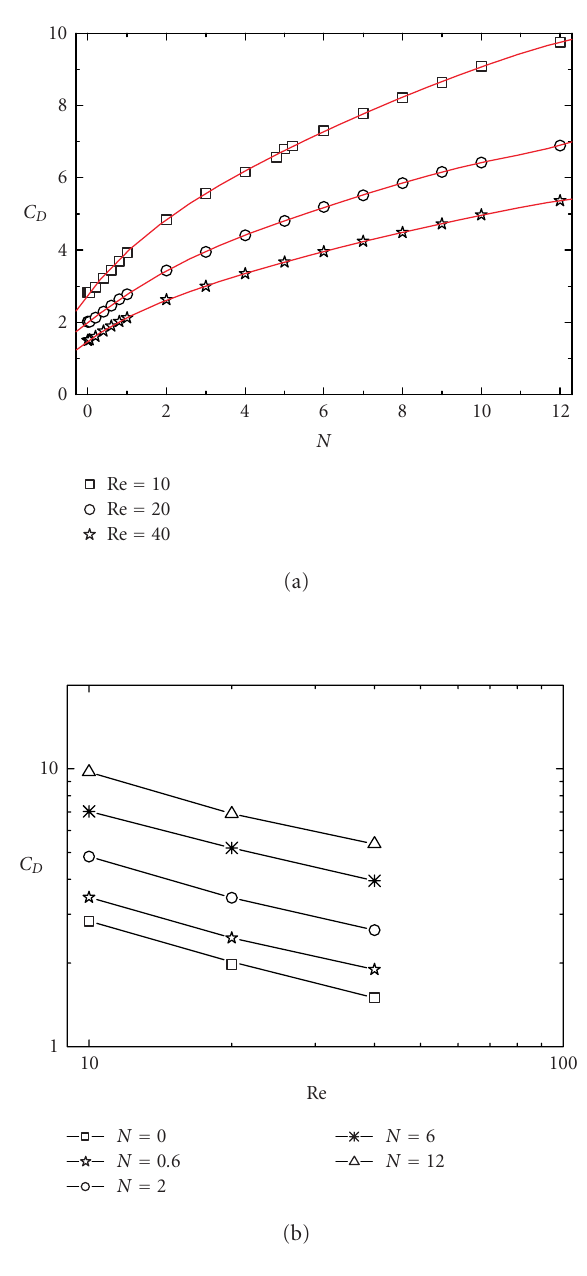
Figure 4.14 . Variation of total drag coe ffi cient C D as a function of (a) interaction parameter N and (b) Reynolds number